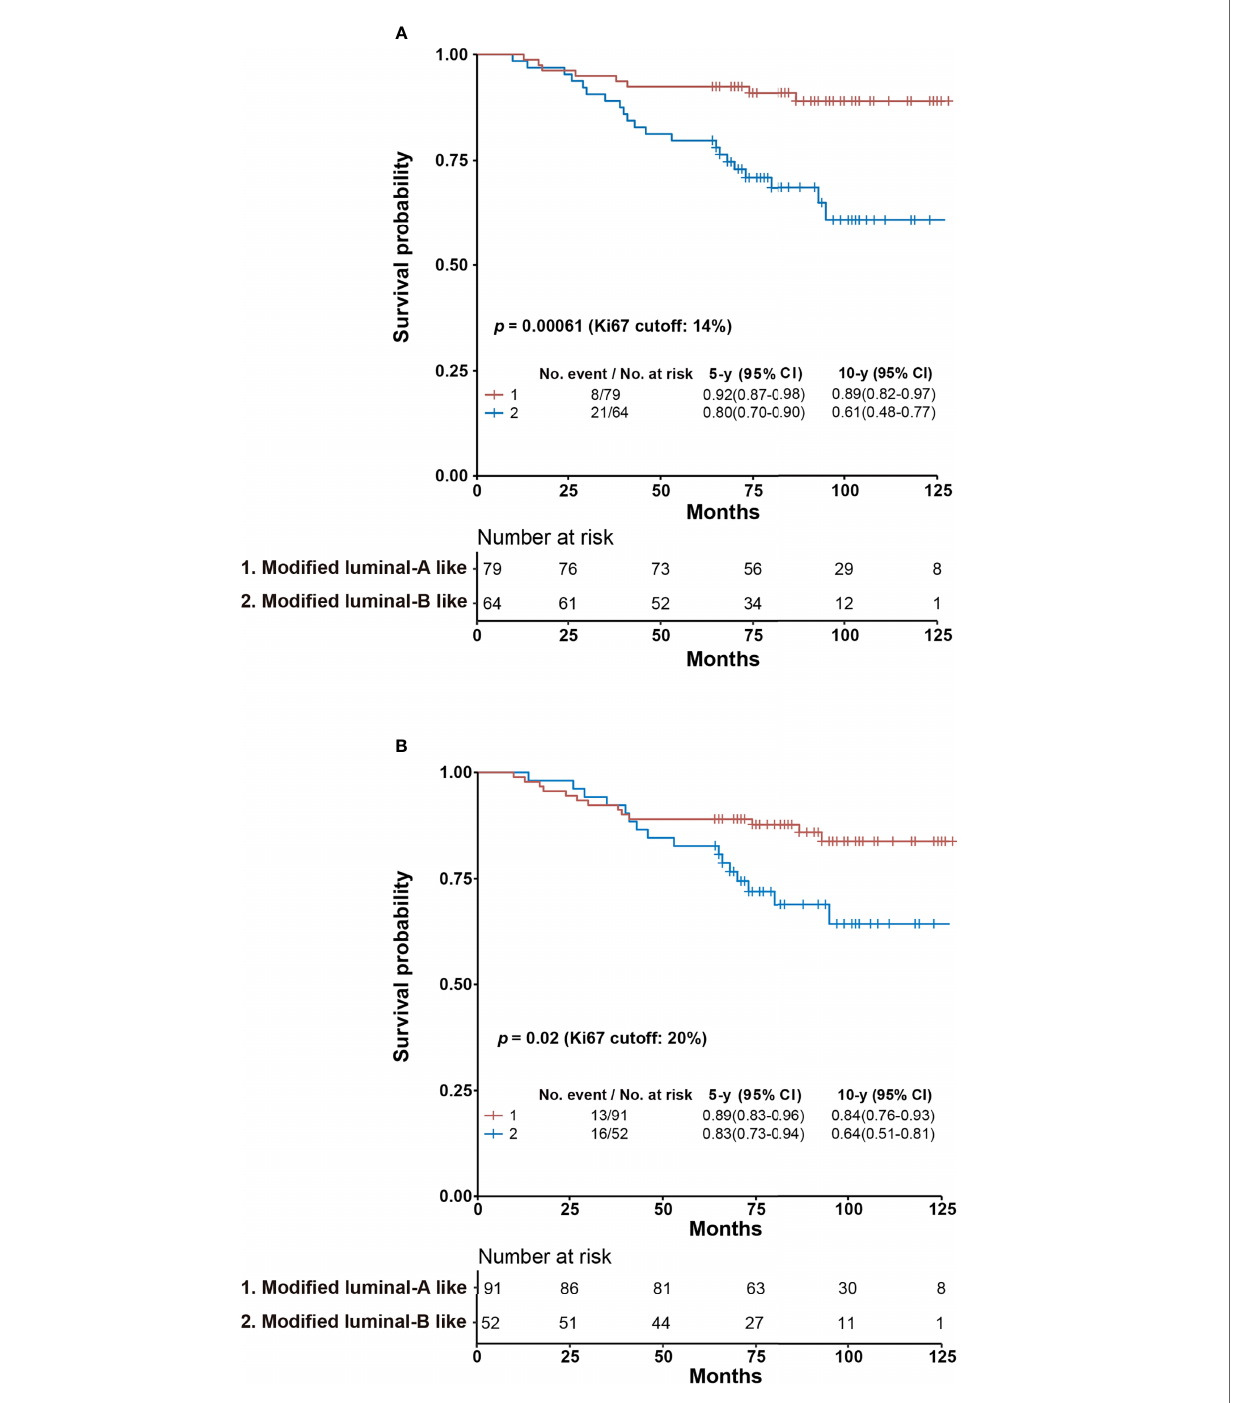
FIGURE 4 | Kaplan – Meier overall survival analysis of modi fi ed Luminal A-like and Luminal B-like subtypes using Ki67 scores of 14% (A) or 20% (B) as cutoff. (A) Specimens with Ki67 <14% and cyclinD1 ≤ 30% from the Luminal B-like subtype based on surrogate assay using a Ki67 score of 14% as cutoff were combined with those of Luminal A-like subtype to become modi fi ed Luminal A-like subtype, while the rest of the Luminal B-like subtype (Ki67 <14% and cyclinD1 >30% or Ki67 ≥ 14%) was named as modi fi ed Luminal B-like subtype. (B) Specimens with Ki67 <20% and cyclinD1 ≤ 30% from Luminal B-like subtype based on surrogate assay using Ki67 score of 20% as cutoff were combined with those of Luminal A-like subtype to become modi fi ed Luminal A-like subtype, while the rest of the Luminal B-like subtype (Ki67 <20% and cyclinD1 >30% or Ki67 ≥ 20%) was named as modi fi ed Luminal B-like subtype. The survival probabilities of modi fi ed Luminal A-like and B-like subtypes were explored by Kaplan – Meier survival analysis with their 5- and 10-year survival probabilities and p -value from log-rank test as reported in the fi gure. CI, con fi dence